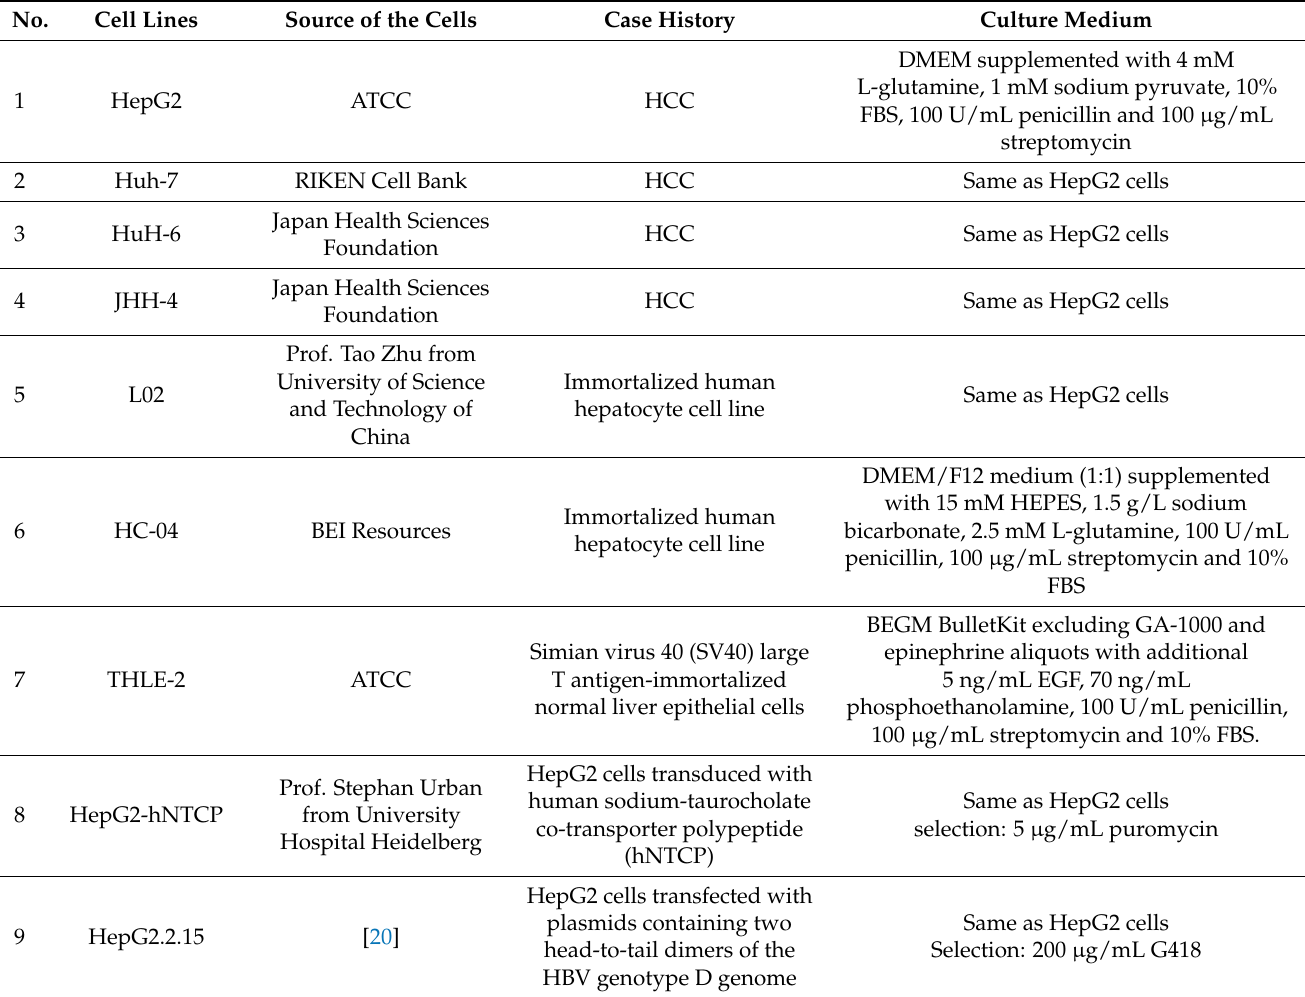
Table 1. Characteristics of cell lines.